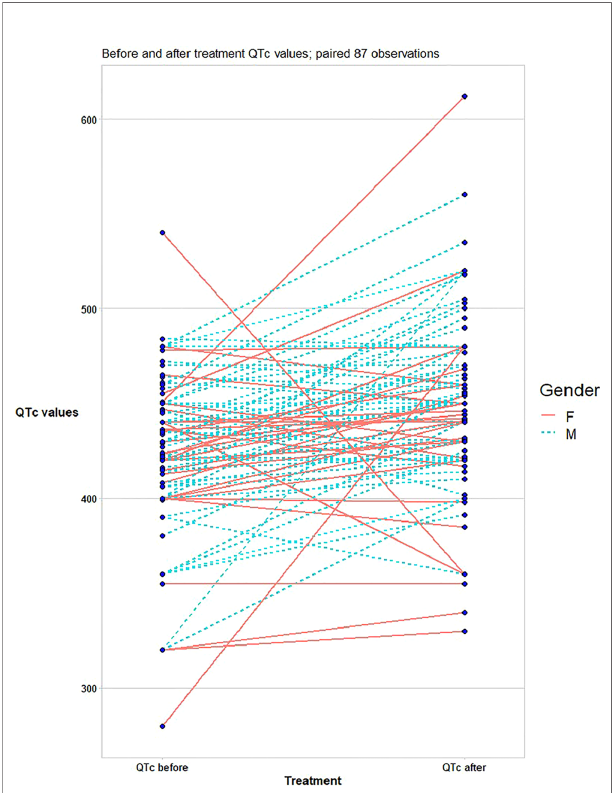
FIGURE 1 | Difference in corrected QT (QTc) between COVID-19 patients at baseline and after triple combination therapy (lopinavir-ritonavir, azithromycin, and hydroxychloroquine).